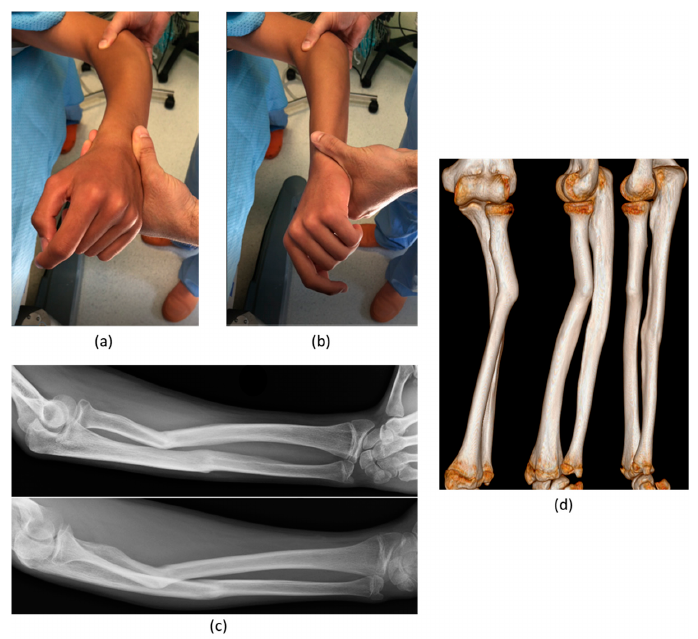
Figure 8. A fifteen-year-old boy affected by post-traumatic nonunion of the forearm with angular and torsional malalignment of both bones and loss of supination. ( a , b ) Preoperative passive range of motion, ( c ) antero-posterior and lateral radiographs. ( d ) CT scan with 3D reconstruction. Appl. Sci. 2020 , 10 , x FOR PEER REVIEW